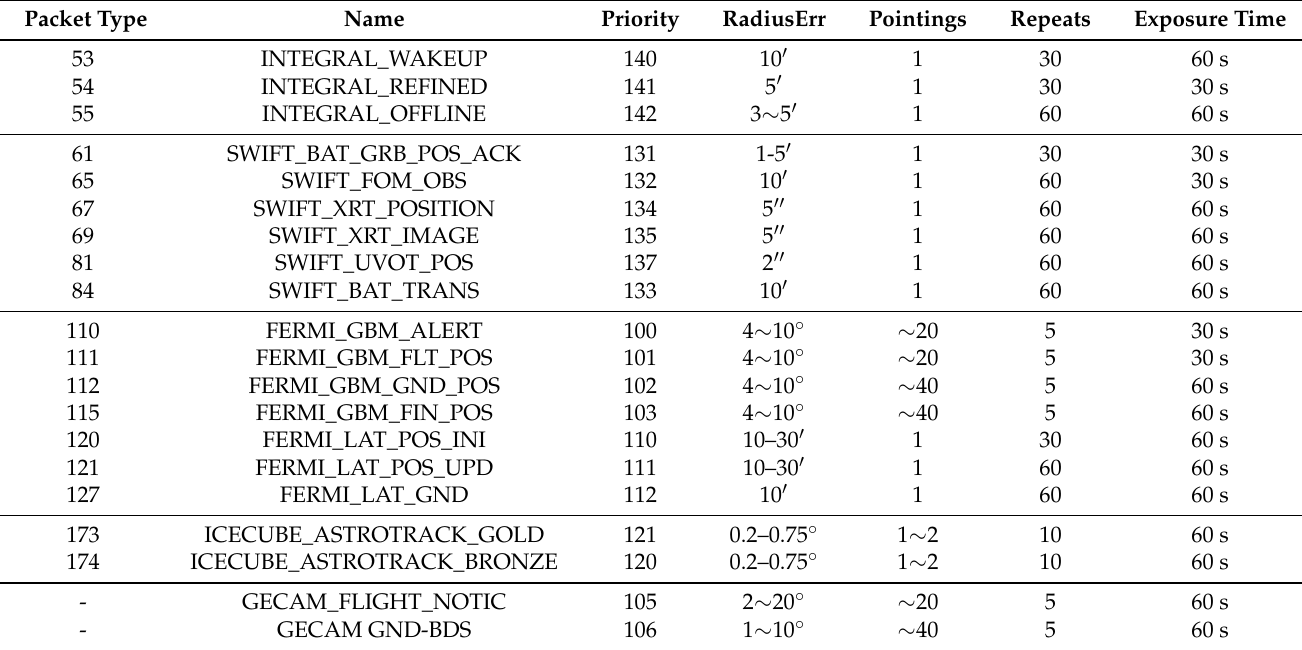
Table 3. ToO Observation